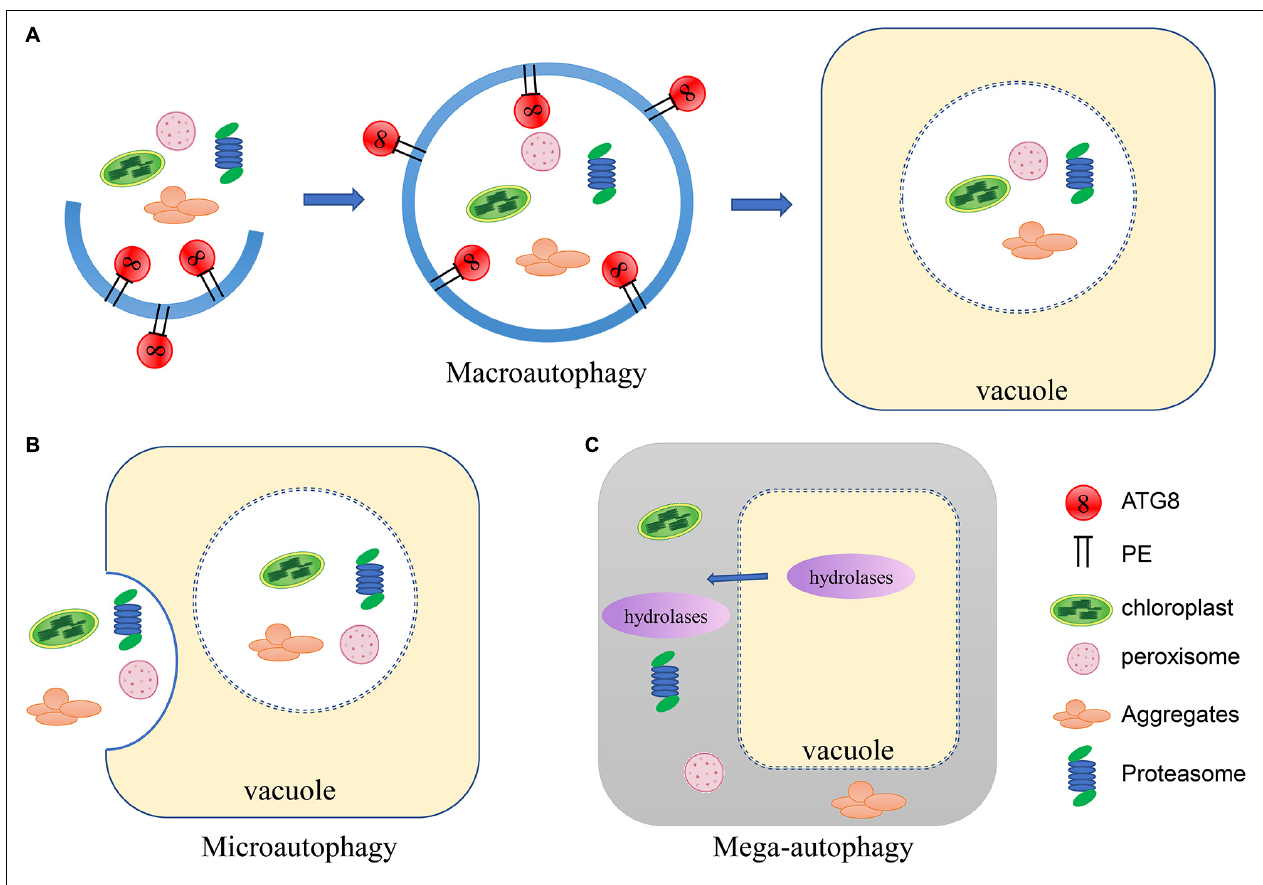
FIGURE 1 | Schematic of the three types of autophagy in plants. (A) In macroautophagy, a cup-shaped phagophore is formed and closes into vesicular autophagosomes as it encircles cytosolic substances. The autophagosome is subsequently delivered to the vacuole. The outer membrane of the autophagosome fuses with the tonoplast and the internal vesicle is released to the vacuolar lumen for degradation. (B) In microautophagy, cytosolic materials are gathered on the tonoplast and directly captured by the vacuole through invagination to be degraded. (C) During mega-autophagy, the vacuolar membrane is permeabilized and ruptures, releasing large amounts of hydrolases into the cytoplasm, causing indiscriminate degradation of cytoplasmic materials.